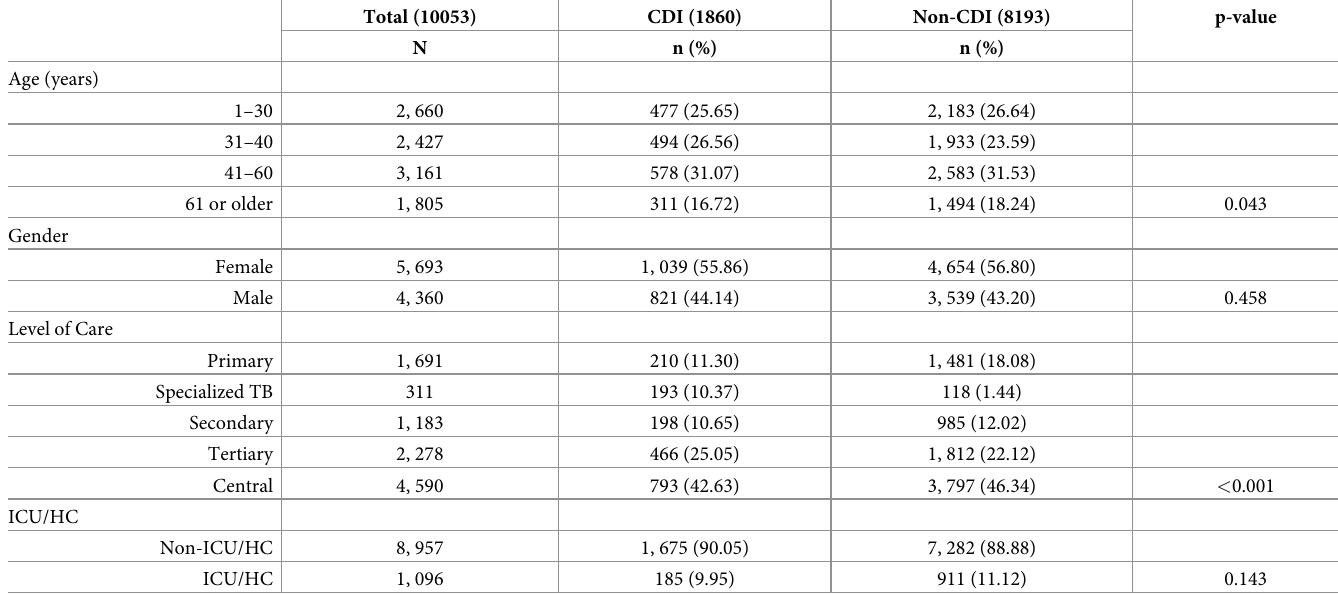
Table 3. Univariate analysis of factors associated with CDI.